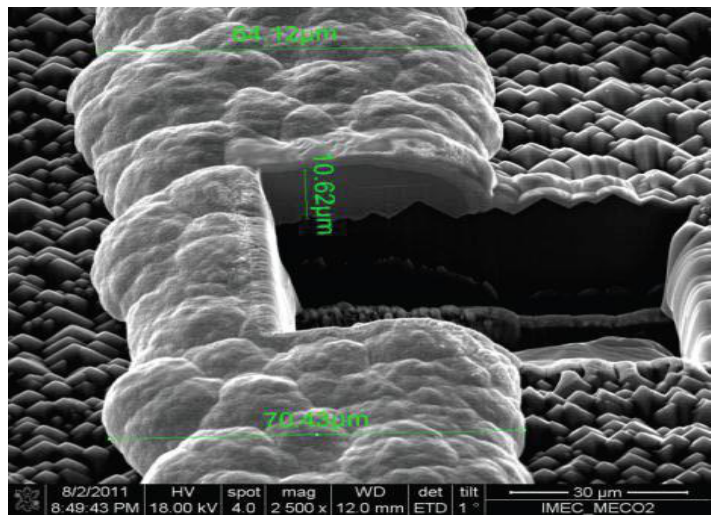
Figure 6. Scanning electron microscopy (SEM) images of the plated lines processed at MECO. Focus ion beam (FIB) cutting was used to analyze the cross-sectional images of the plated lines. The electroplated copper above nickel layer is covered by Ag capping layer at the top, reprinted with permission from the authors (2014)